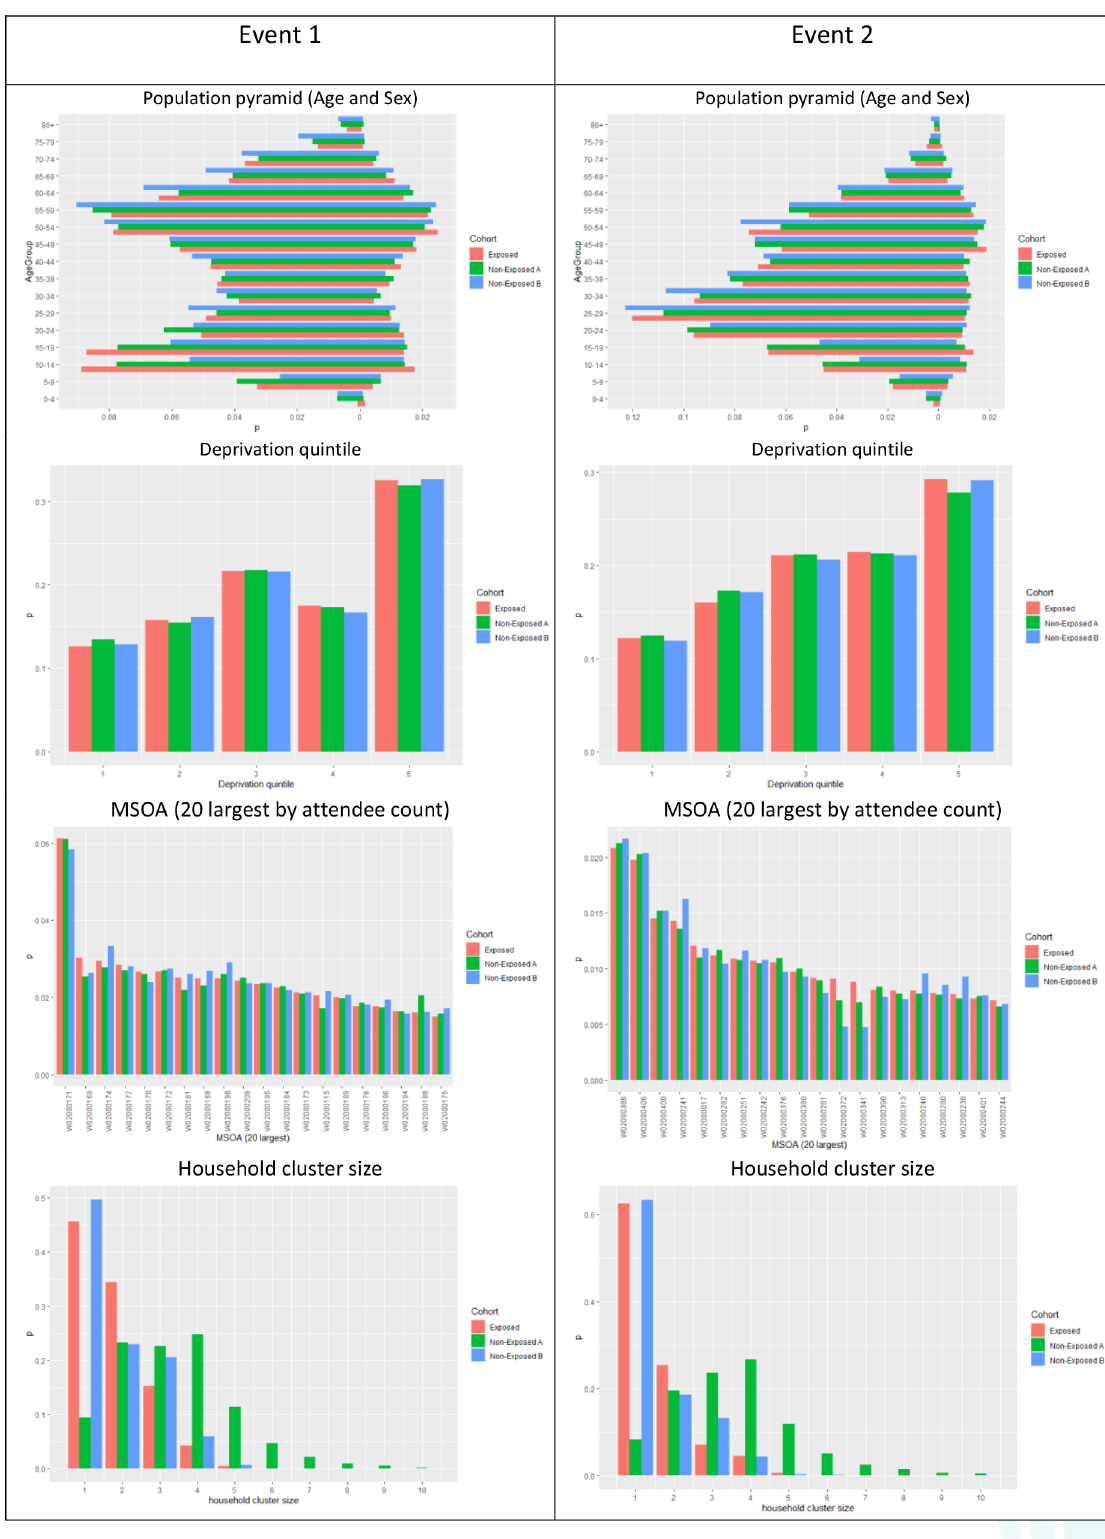
Figure S3: Distributions of matching variables for each cohort, for each